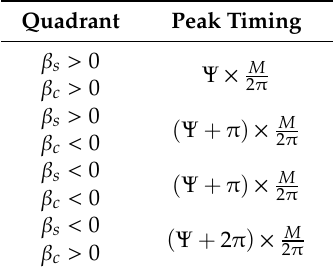
Table 6. Formulas used to calculate peak timing from an estimate of phase shift ψ , harmonic regression estimates of β s and β c , and the length of the annual cycle